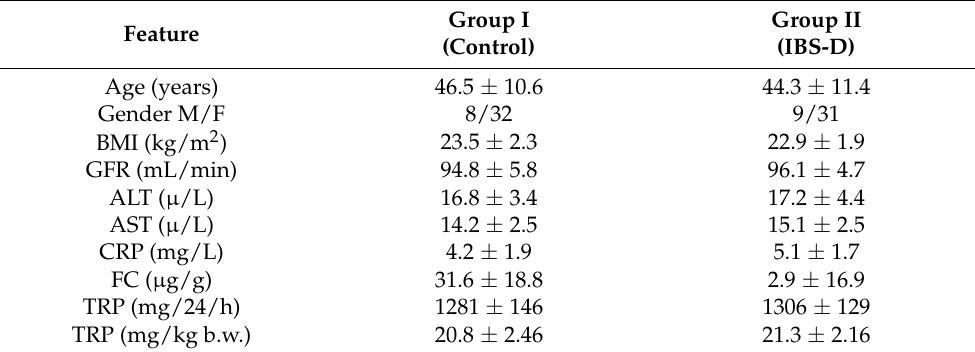
Table 1. General characteristics and the selected biochemical blood parameters and tryptophan intake in the control group ( n = 40) and in patients with diarrhea-predominant irritable bowel syndrome (IBS-D, n = 80); average ± SD.